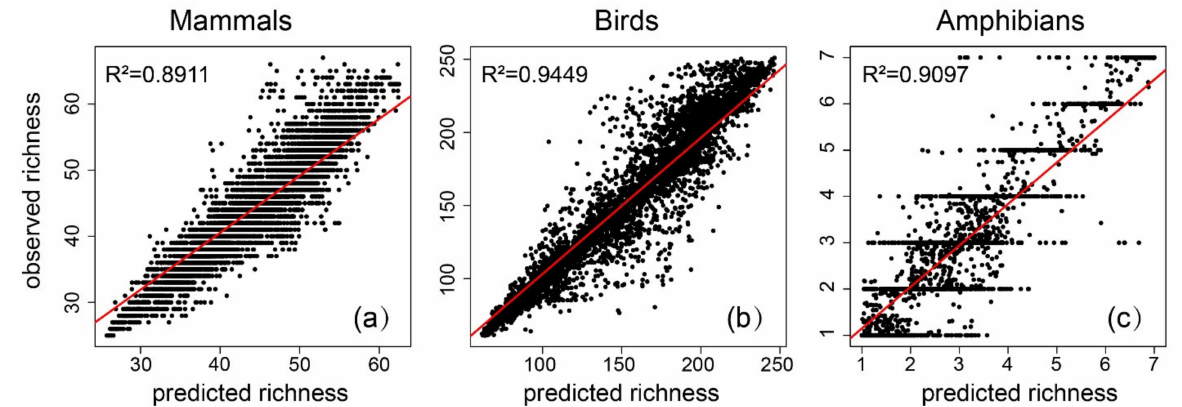
Figure 7. The relationships between the observed richness and predicted richness, based on RF with both dynamic habitat indices (DHIs) and climate variables, of ( a ) mammals, ( b ) birds, and ( c ) amphibians.